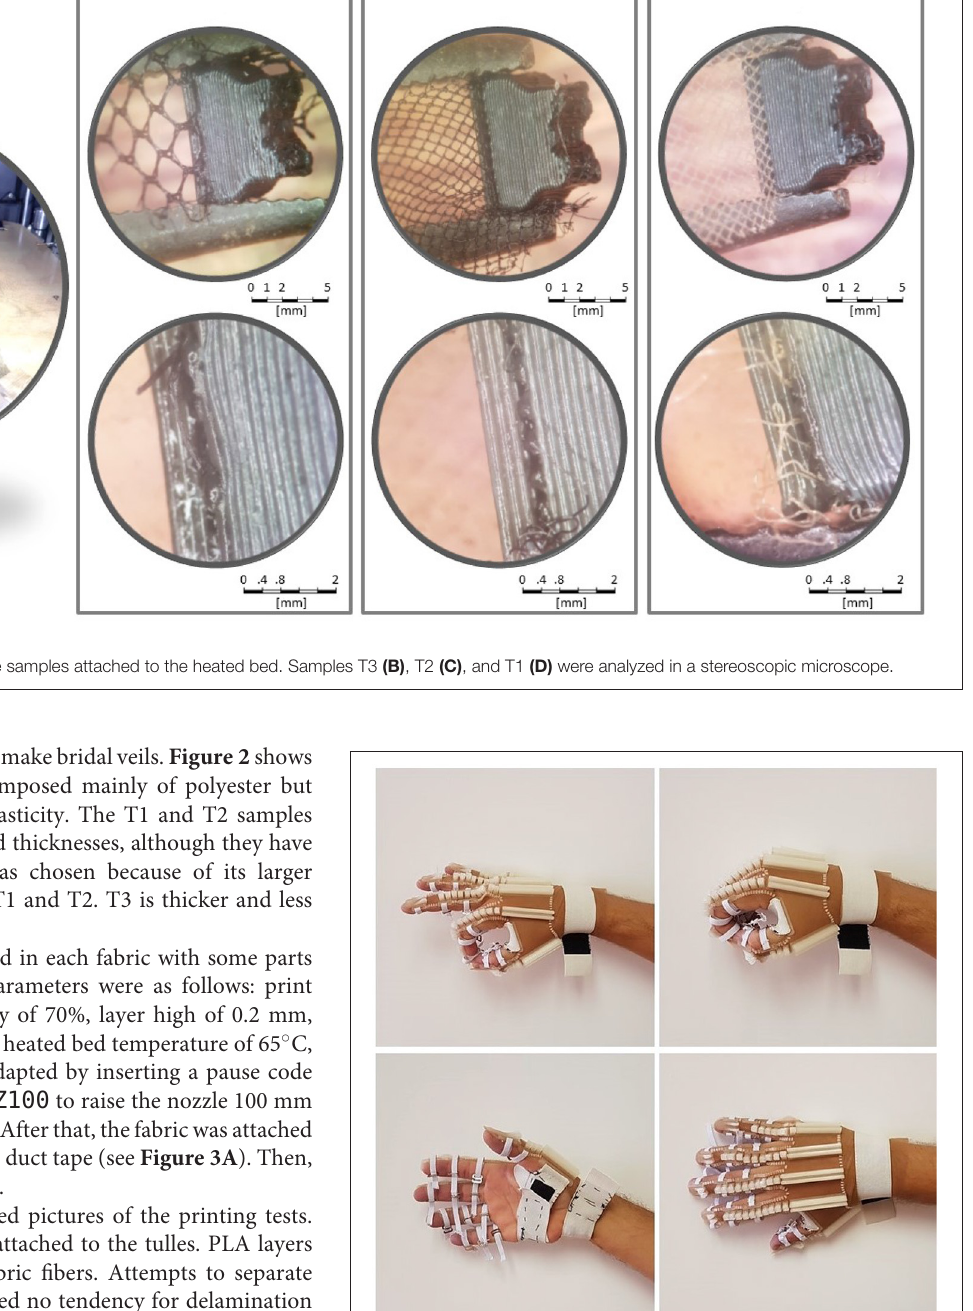
same printing parameters described in section 2.1.1 were